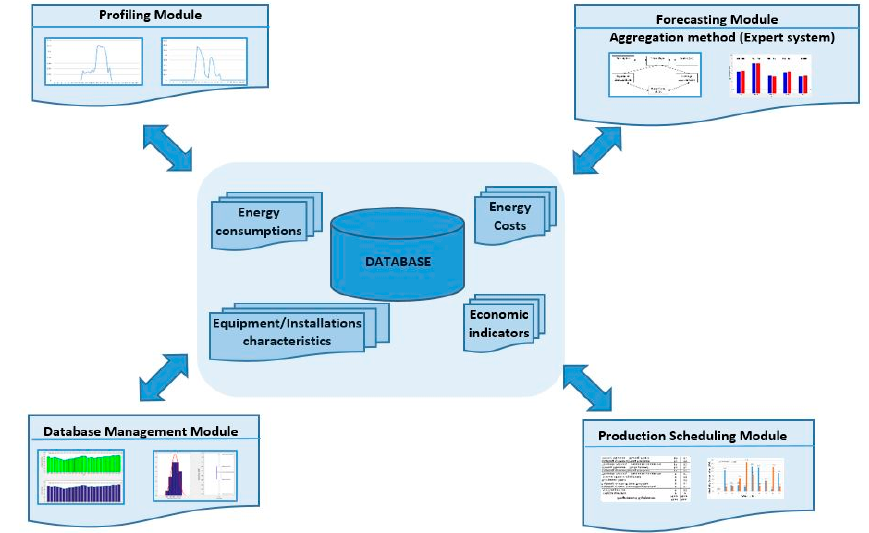
Figure 4. The structure of decision support platform.